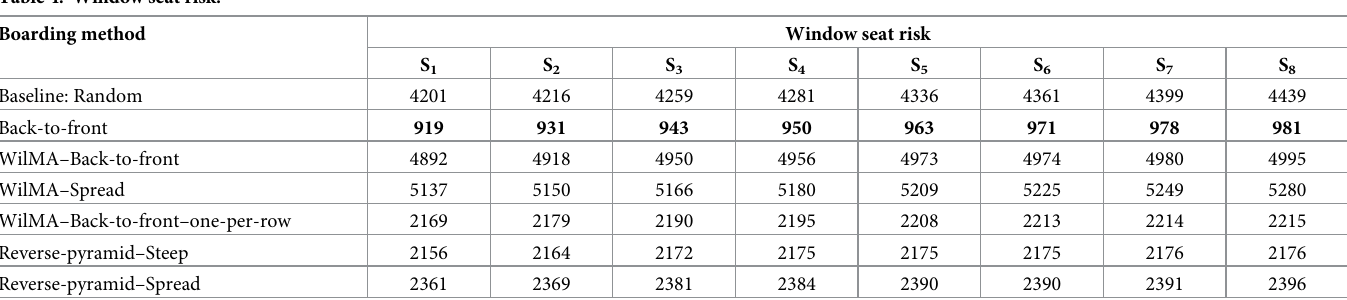
Table 4. Window seat